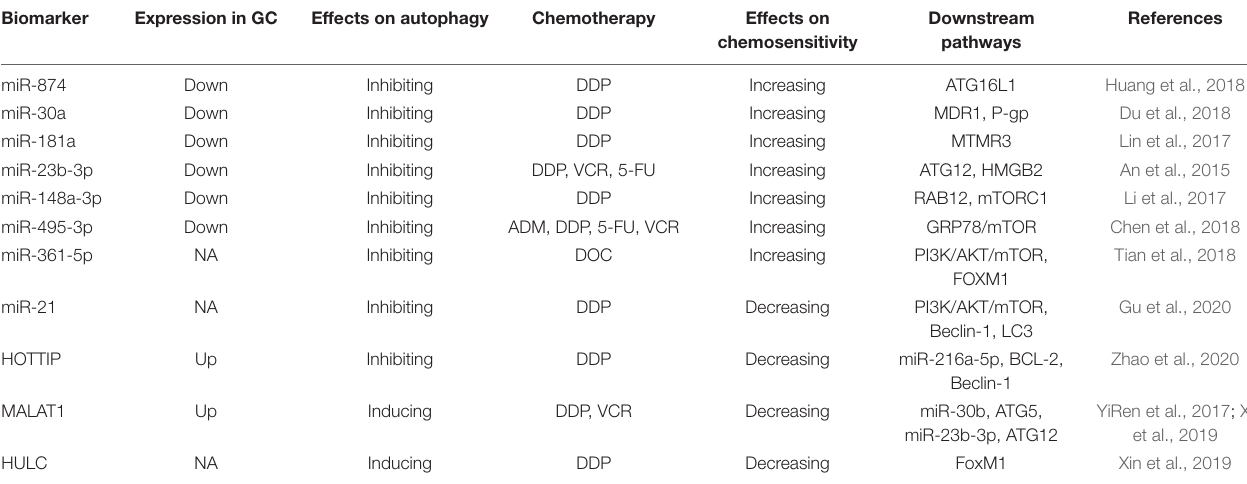
TABLE 2 | Key regulatory non-coding RNAs in autophagy-mediated chemoresistance of gastric cancer.